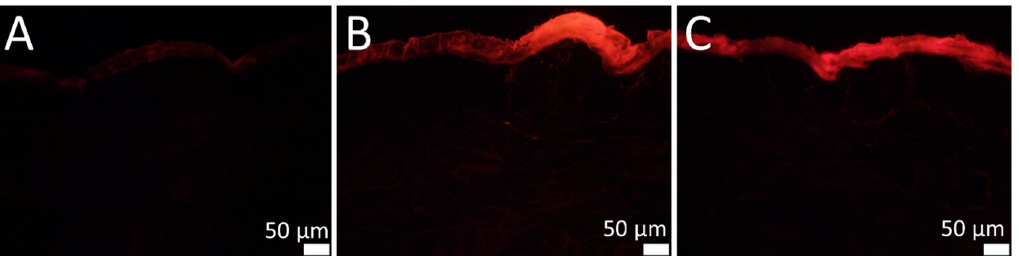
Figure 6. Fluorescence microscopic images. Magnification: 200-fold. ( A ): Untreated skin. ( B ): Skin treated with SN bulk material. ( C ): Skin treated with SN PlantCrystals stabilized with TPGS.